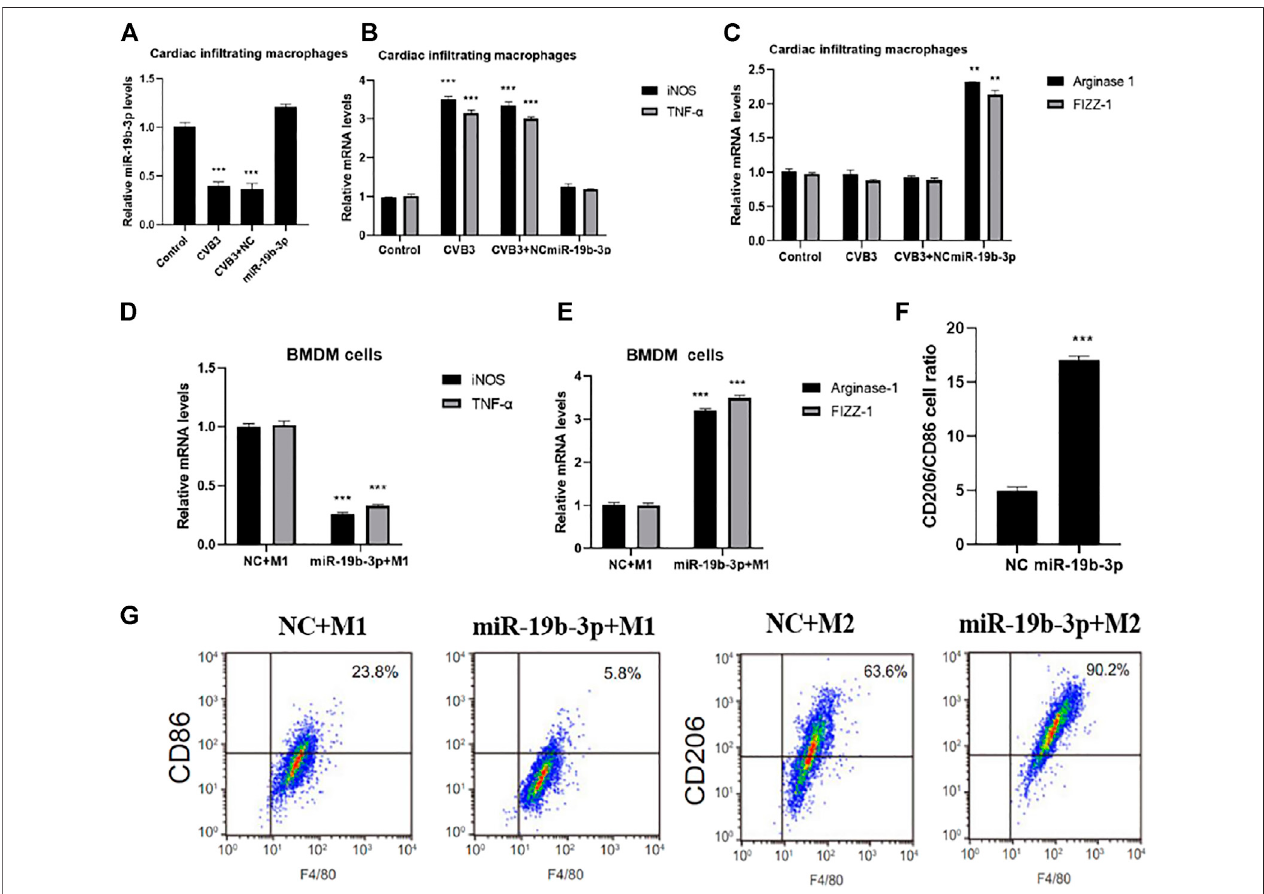
FIGURE 3 | Comparison of M1/M2 polarization of macrophages under different treatments. PCR detection of miR-19b-3p (A) , inducible nitric oxide synthase and tumor necrosis factor- α (B) , arginase-1 and Fizz-1 (C) expressions in cardiac in fi ltrating macrophages, PCR detection of (D) inducible nitric oxide synthase and TNF- α 5 (D) , arginase-1 and FIZZ-1 (E) in BMDM cells under different polarization conditions, (F) CD206/CD86 cell ratio detected by fl ow cytometry, and (G) representative images of fl ow cytometry assays. p p < 0.05, pp p < 0.01, ppp p <